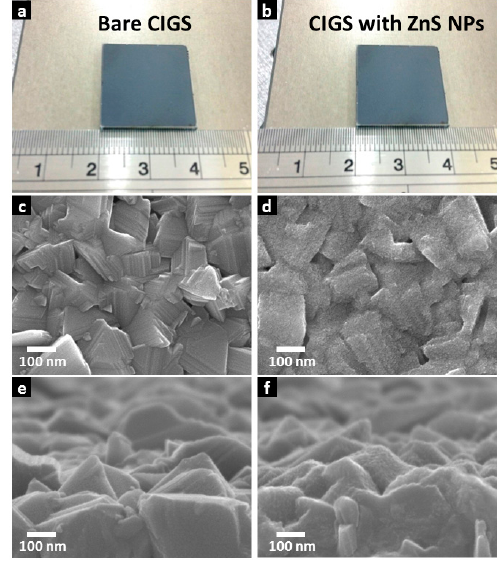
Figure 3. Photograph of a CIGS thin film ( a ) before and ( b ) after ZnS NPs overgrowth. And top view SEM images of CIGS thin film ( c ) before and ( d ) after ZnS NPs overgrowth. Also, SEM images with a tilted view over CIGS thin film ( e ) before and ( f ) after ZnS NPs overgrowth. Dark current of the thermally decomposed ZnS NPs device and the CBD ZnS device with the highest efficiency in each category are shown in Figure S2 of Supplementary Information, in which a better coverage of thermally decomposed ZnS NPs is reflected by the lower shunt leakage current